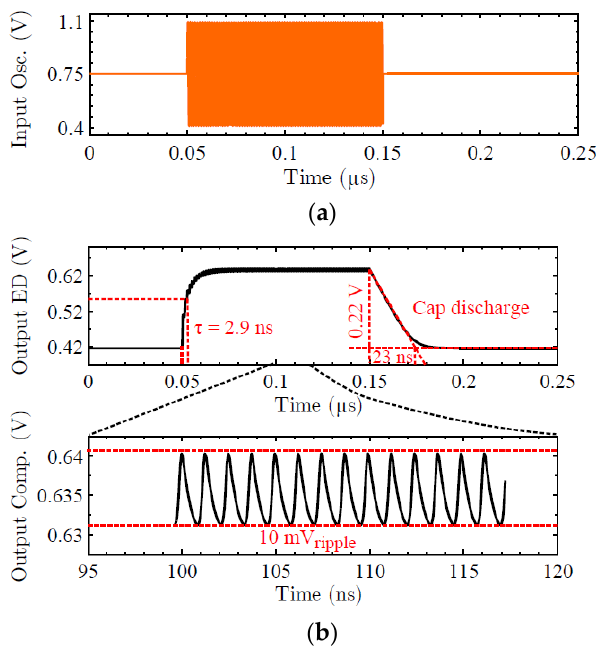
Figure 8. ( a ) Oscillator input signal; ( b ) ED output waveform and voltage ripple.